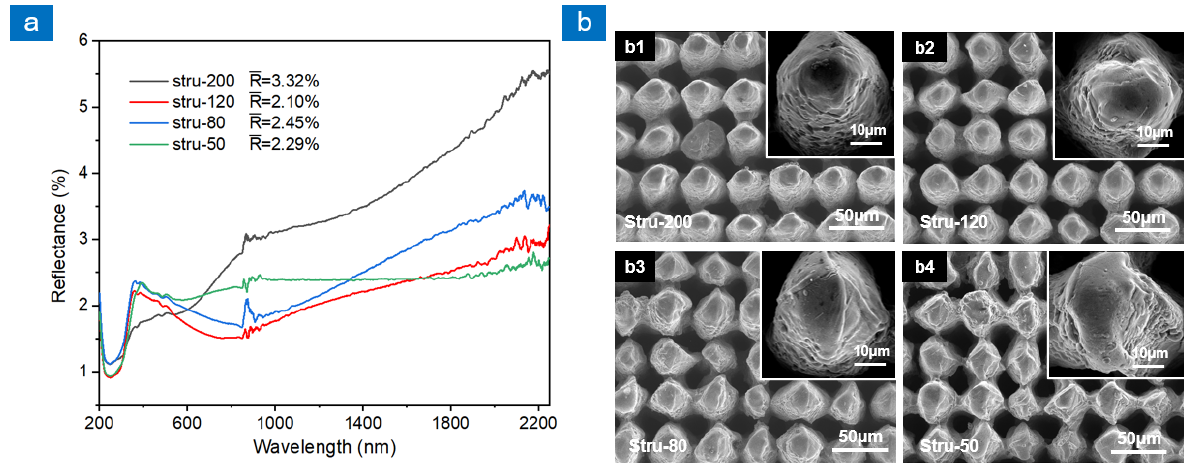
Figure 4. Reflection spectra and SEM images of multi-scale structures at different laser scanning speeds. ( a ) Reflectance spectra of four samples, ( b ) SEM images of four samples: (b1) the scanning speeds is 200mm/s, (b2) the scanning speeds is 120mm/s, (b3) the scanning speeds is 80mm/s, (b4) the scanning speeds is 50mm/s.